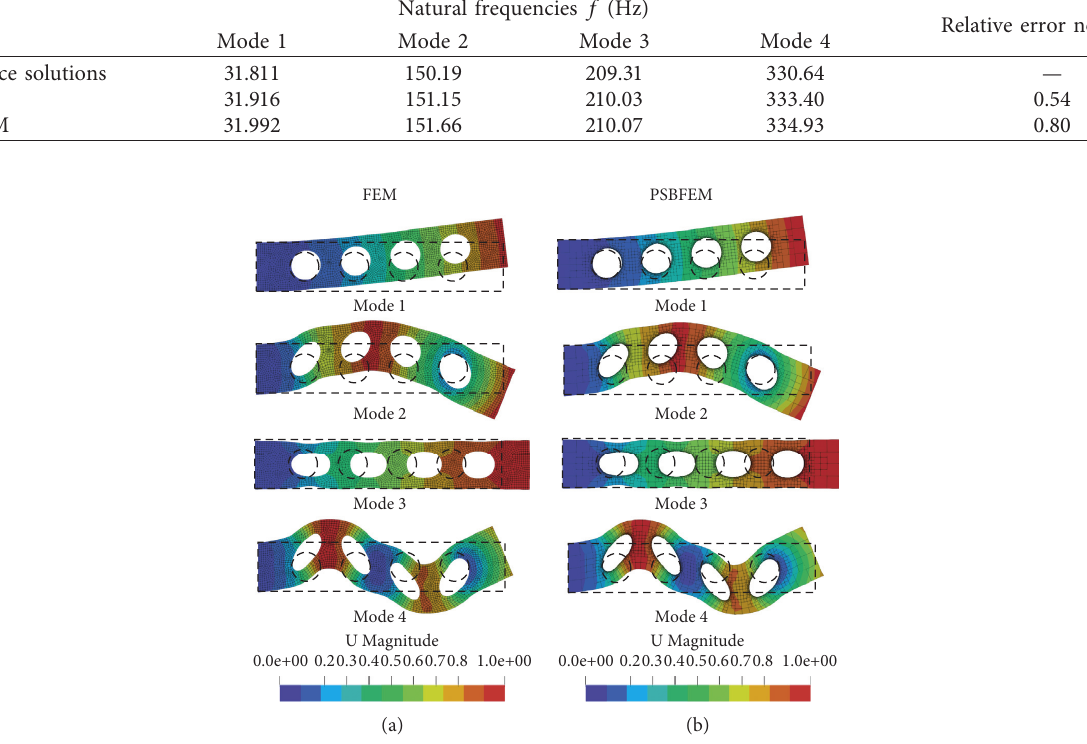
Figure 9: The first four modes of a multihole panel: (a) modes of the FEM and (b) modes of the PSBFEM.